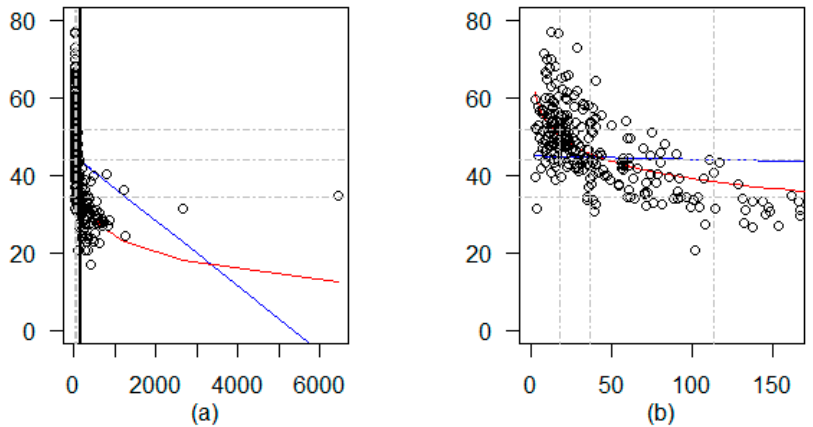
Figure 4. ( a ) Axis OX population density. Axis OY rates of elderly women as victims of gender violence. ( b ) Zoom of previous one.